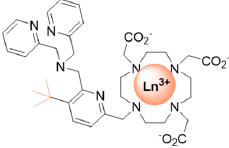
Figure 10. Parashift probe for Zn 2+ detection.